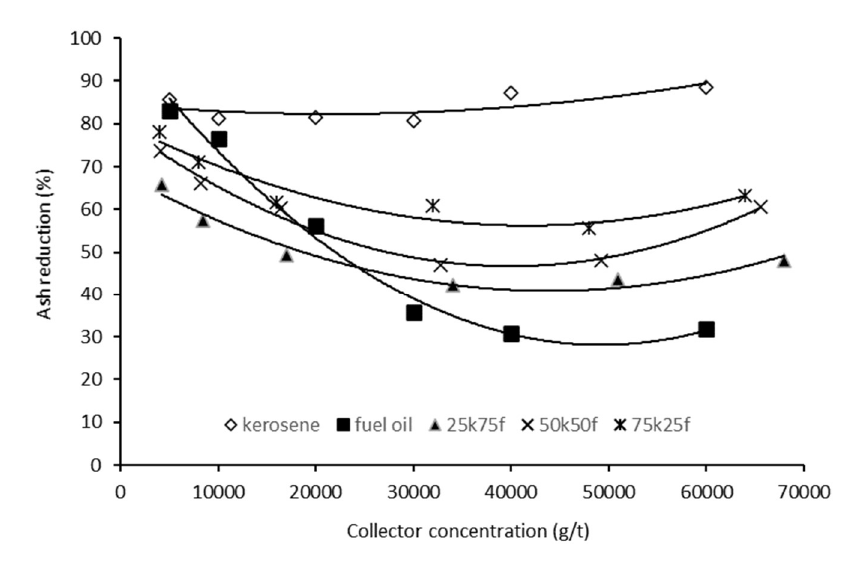
Fig.9. Effect of the concentration of kerosene and fuel oil mixtures on ash